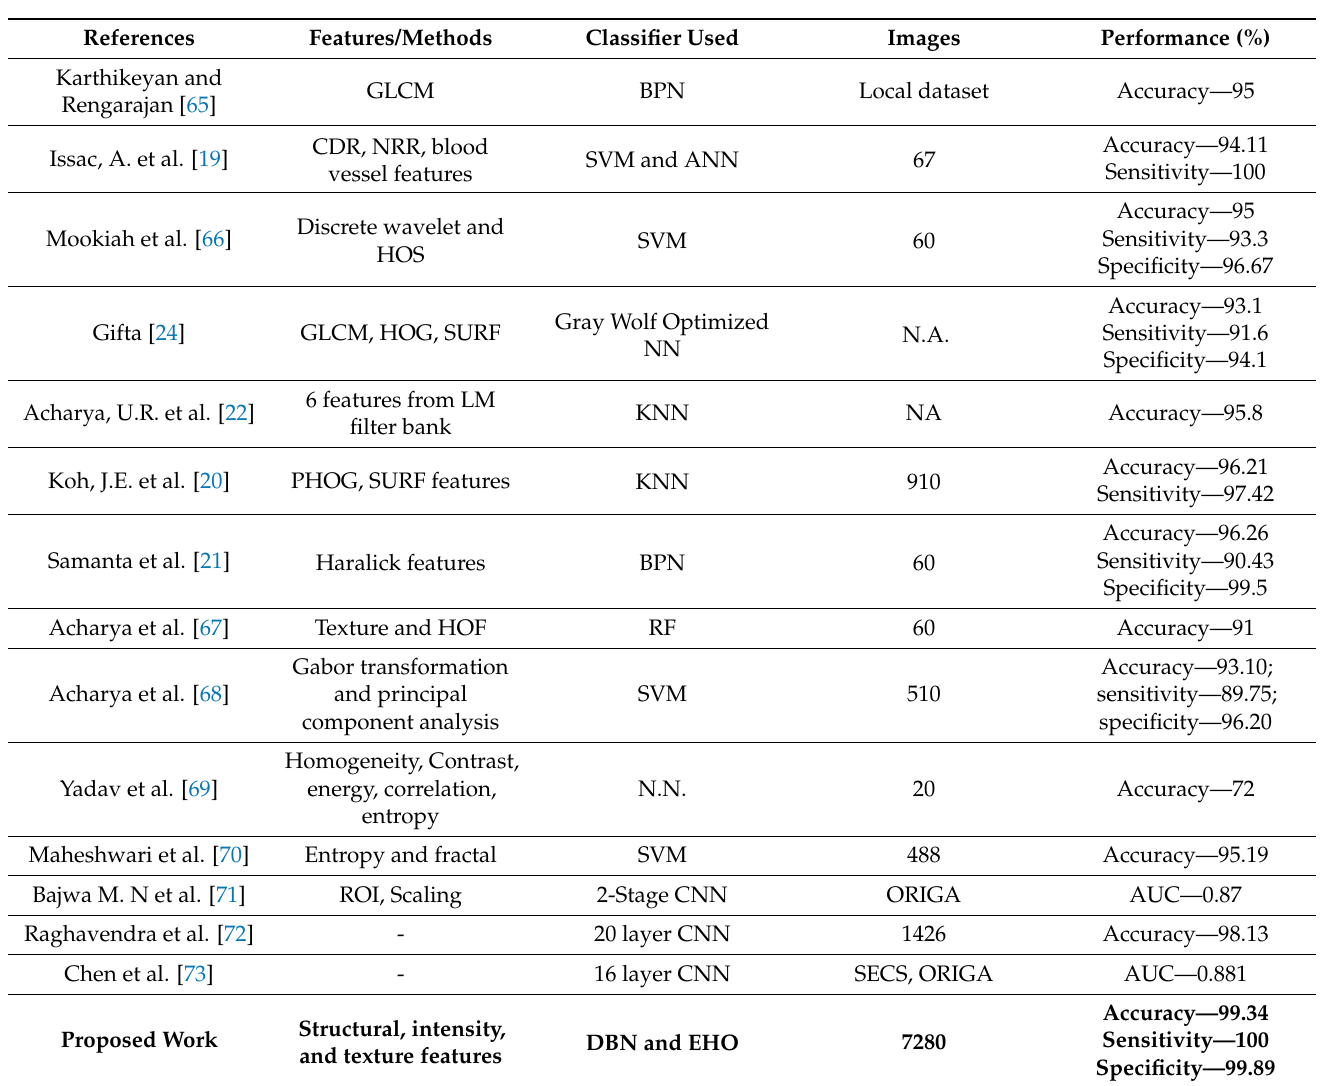
Table 11. Comparison of proposed